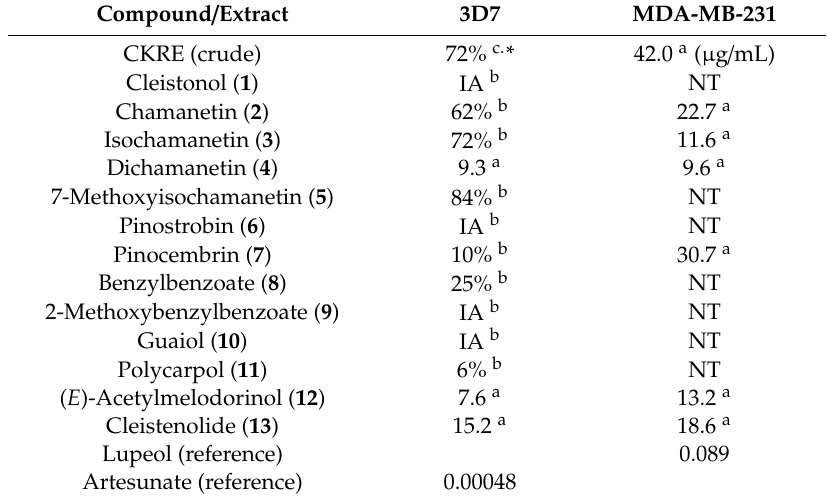
Table 2. Antiplasmodial and cytotoxic activities (IC 50 and % inhibition) of the selected constituents of Cleistochlamys kirkii